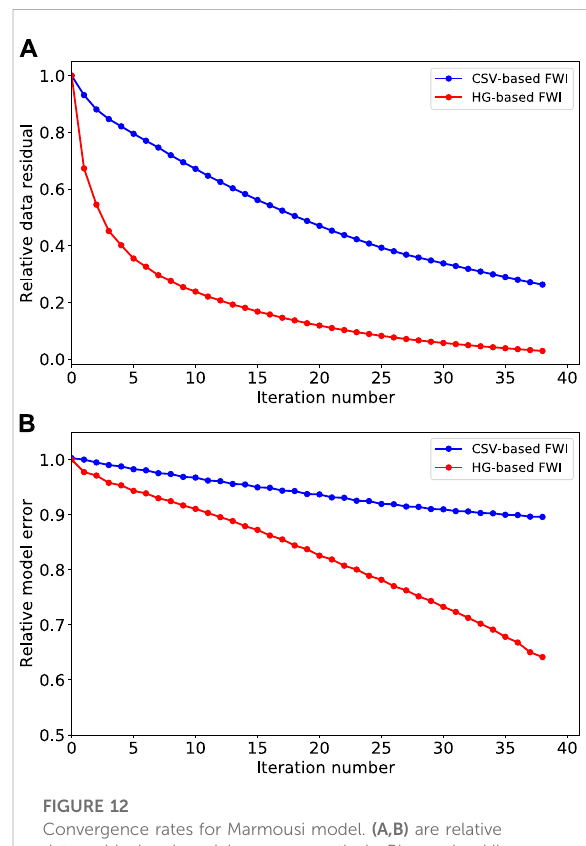
FIGURE 12 Convergence rates for Marmousi model. (A,B) are relative data residual and model error, respectively. Blue and red lines are results from CSV-based FWI and the proposed